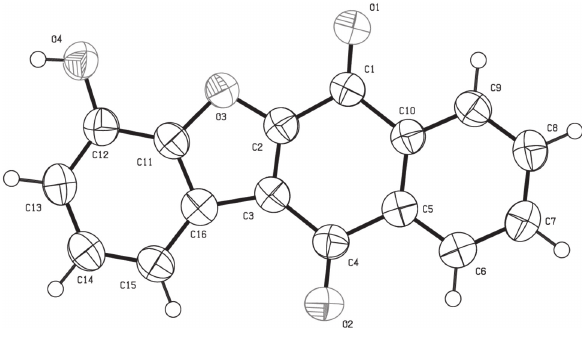
Table 1: Data collection and handling.